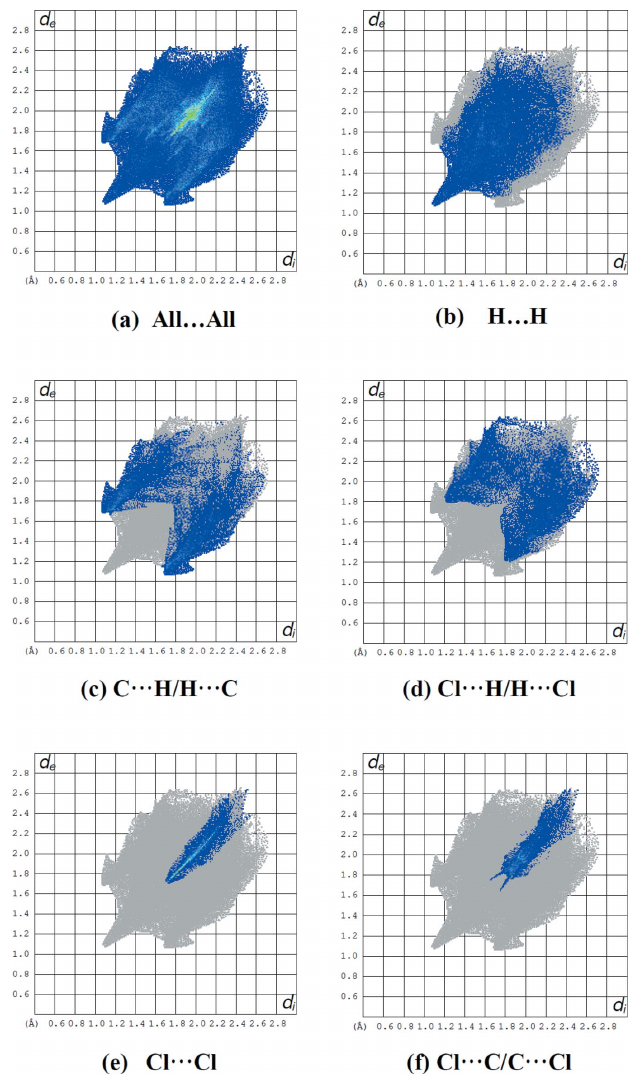
Figure 6 The full two-dimensional fingerprint plots for the title compound, showing ( a ) all interactions, and delineated into ( b ) H (cid:2)(cid:2)(cid:2) H, ( c ) C (cid:2)(cid:2)(cid:2) H/ H (cid:2)(cid:2)(cid:2) C, ( d ) Cl (cid:2)(cid:2)(cid:2) H/H (cid:2)(cid:2)(cid:2) Cl, ( e ) Cl (cid:2)(cid:2)(cid:2) Cl and ( f ) Cl (cid:2)(cid:2)(cid:2) C/C (cid:2)(cid:2)(cid:2) Cl interactions. The d i and d e values are the closest internal and external distances (in A˚ ) from given points on the Hirshfeld